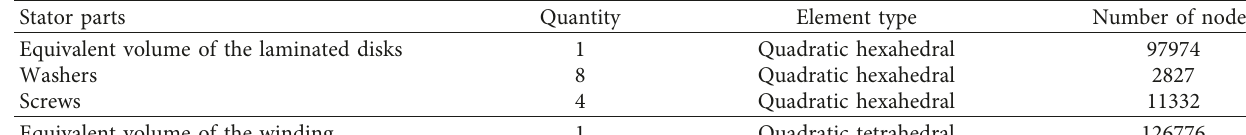
Table 1: Approximate characteristics of the numerical model of the stator.